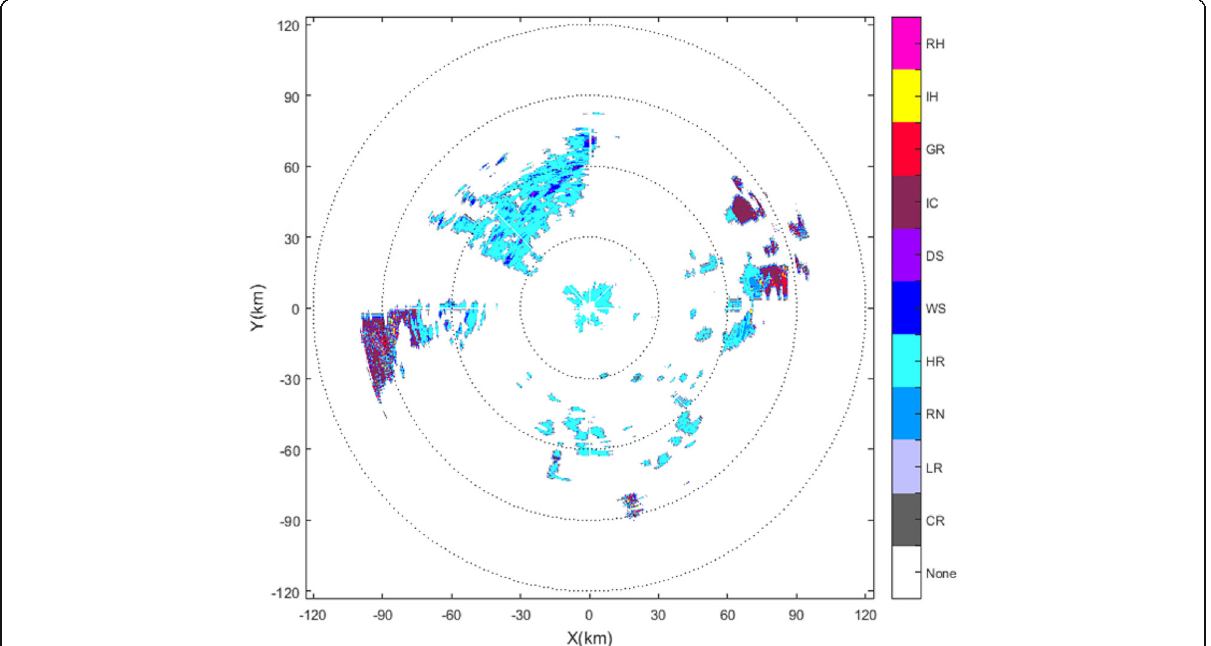
Fig. 6 The identification result of hydrometeor type corresponding to the case of 27 March